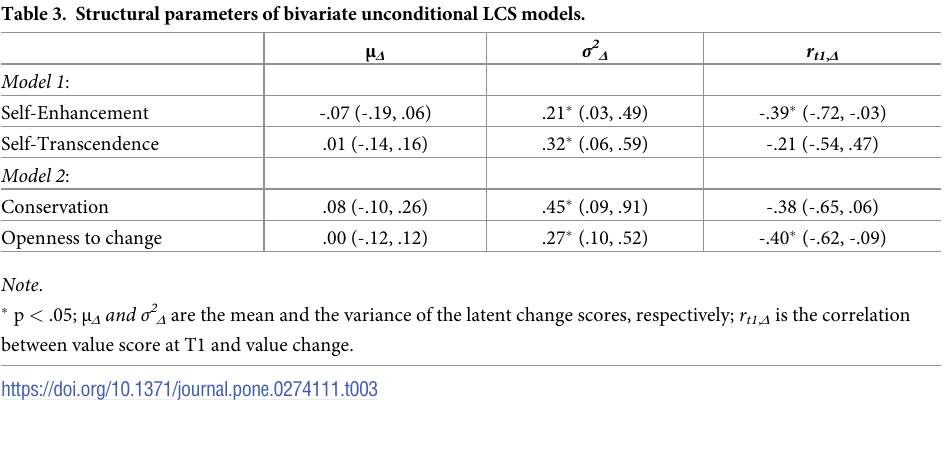
(conservation and openness to change): χ 2 (52) = 71.824, p = .04, CFI = .976, RMSEA = .045 (.012, .069), SRMR = .064. Standardized factor loadings were in the range .61 –.84 in Model 1 and .40 –.92 in Model 2. Omega reliability coefficients at T1 and T2 were respectively .76 and .69 for self-enhancement, .62 and .70 for self-transcendence, .57 and .54 for conservation, .67 and .67 for openness to change. The mean ( μ ) and variance ( σ 2 ) of the latent change scores Δ Δ are reported in Table 3.